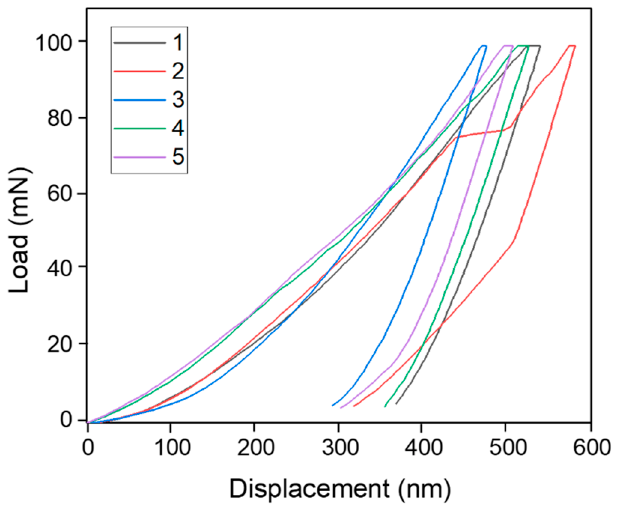
Figure 6. Nano-indentation of ZrB 2 –SiC–TaC.